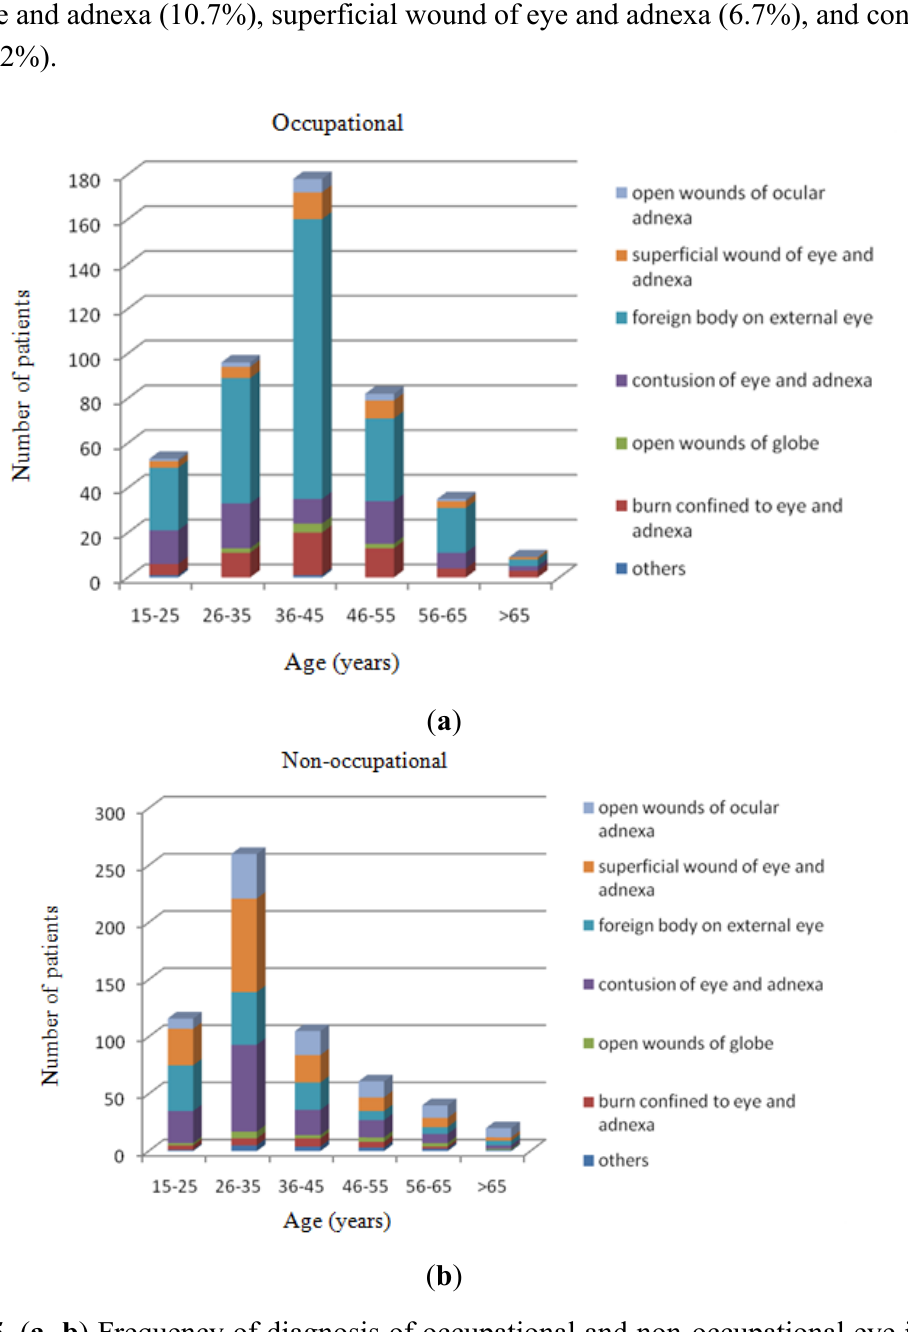
Figure 5. ( a, b ) Frequency of diagnosis of occupational and non-occupational eye injuries by